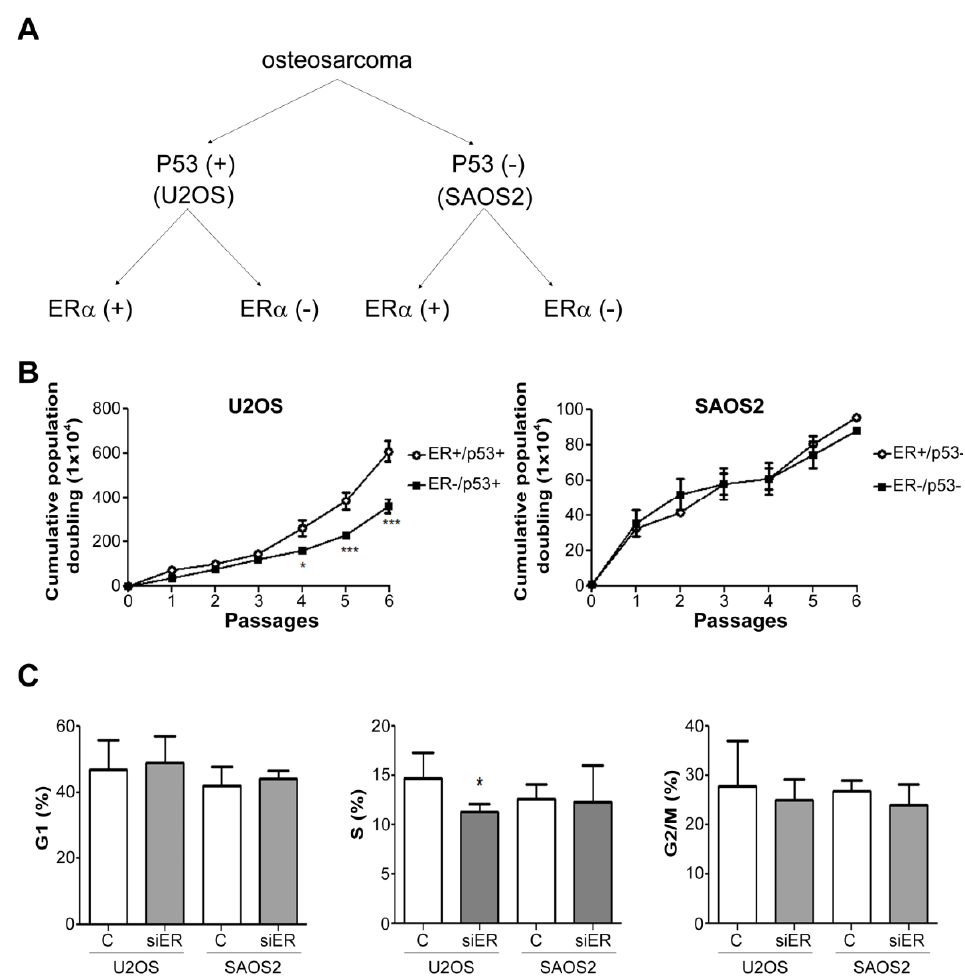
Figure 2. ER α knockdown suppressed the growth rate of the P53-positive U2OS cells but not the P53-negative SAOS cells. ( A ) Flow chart of the experimental design. Two types of OS cell lines were tested for the effects of ER α , including P53(+) U2OS cells and P53( − ) SAOS2 cells. ( B ) The cells were continuously seeded in complete medium for 6 passages, and the cumulative population doublings were calculated by trypan blue assay. ( C ) The cell cycle of individual cells was analyzed by flow cytometry. * p < 0.05, and *** p < 0.005 compared to the parental cells in the individual passages.